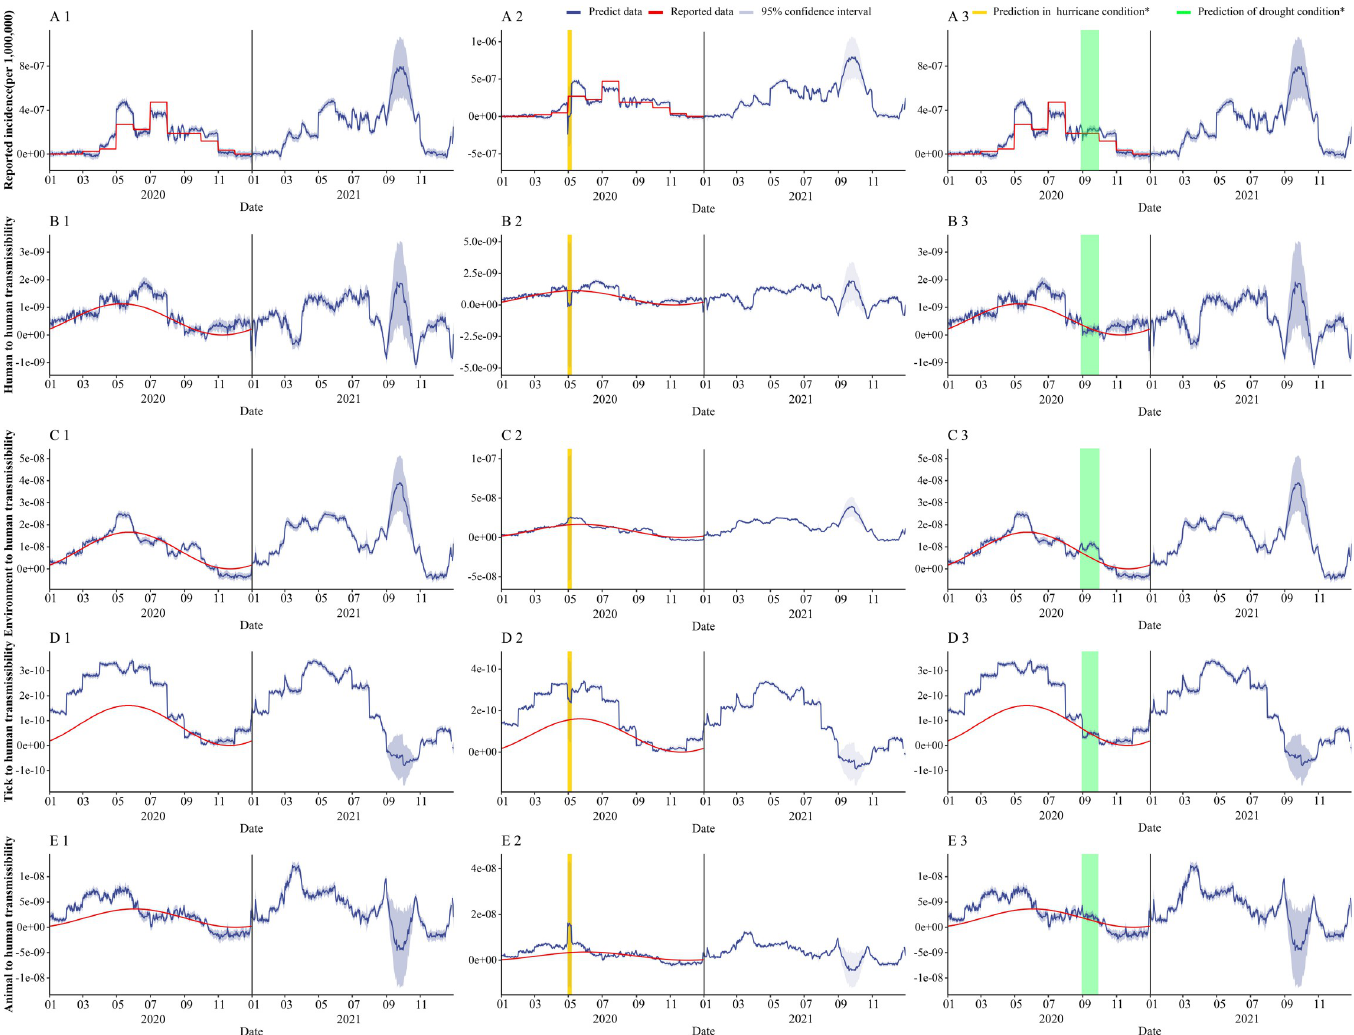
Fig 8. GAM predicts the incidence of SFTS, infection coefficient and the impact of extreme weather in Jiangsu Province in 2020–2021. Part 1: the prediction of GAM about SFTS incidence and different infection coefficients in normal weather; Part 2: the prediction of GAM about SFTS incidence and different infection coefficients in hurricane; Yellow part is the duration of the hurricane; Part 3: the prediction of GAM about SFTS incidence and different infection coefficients in drought; green part is the duration of the drought).